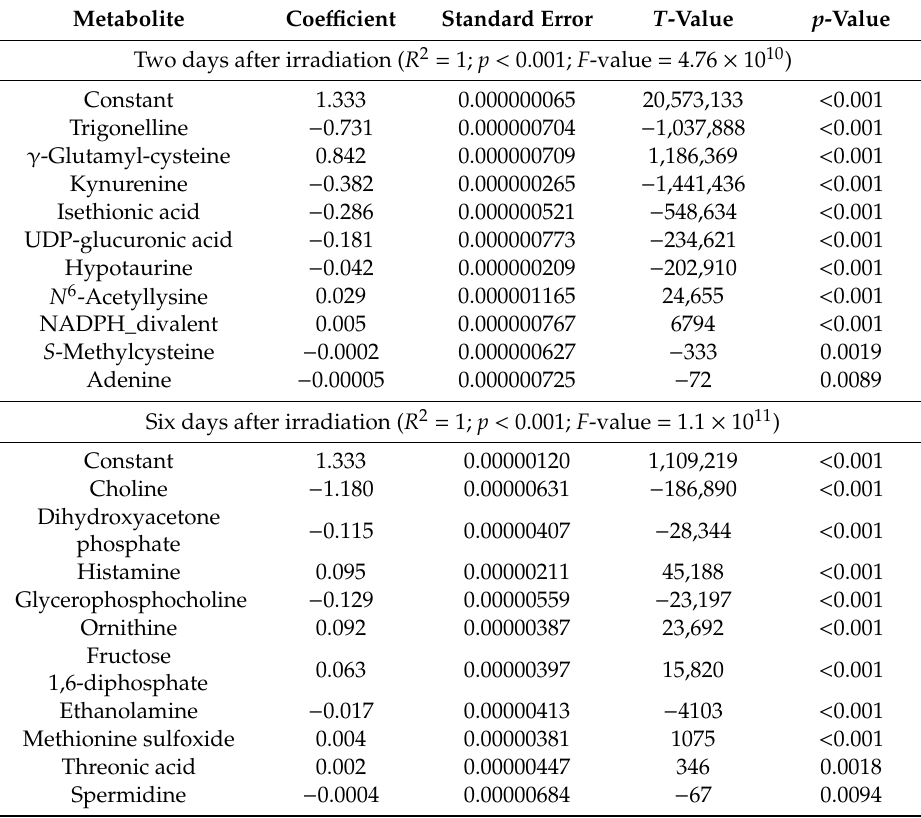
Table 2. Results of stepwise regression